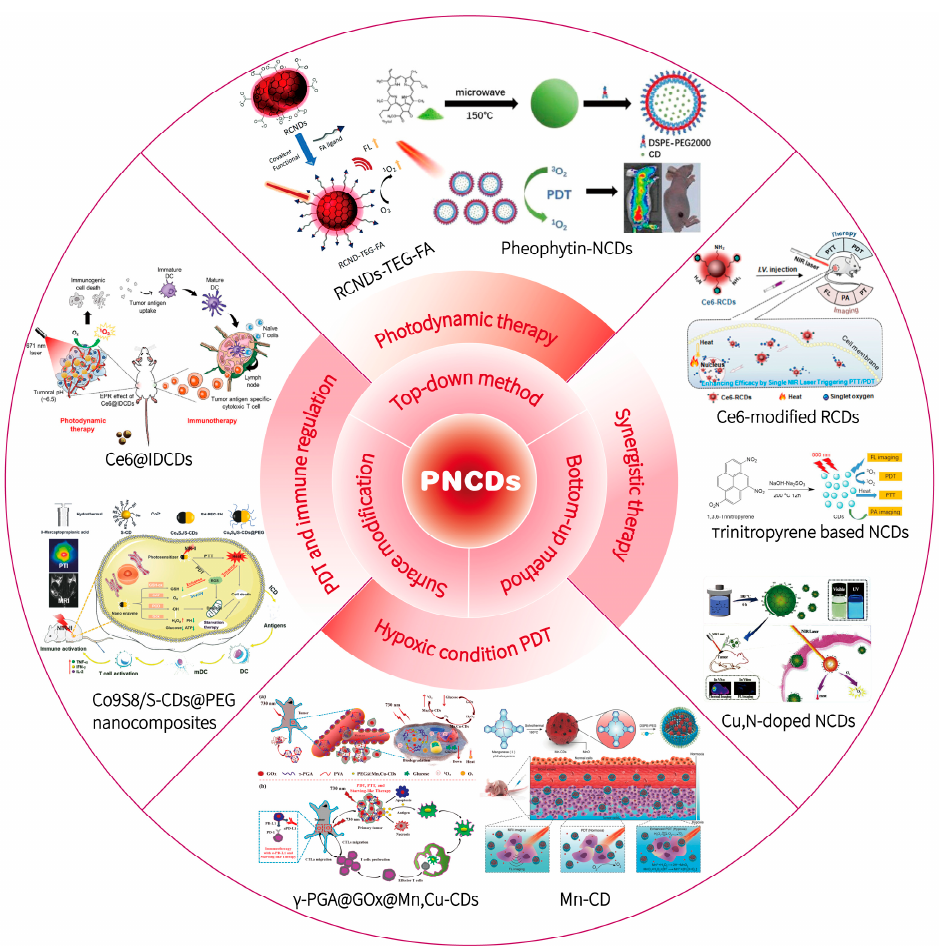
Figure 2. Schematic illustration of PNCDs preparation and PDT related application.